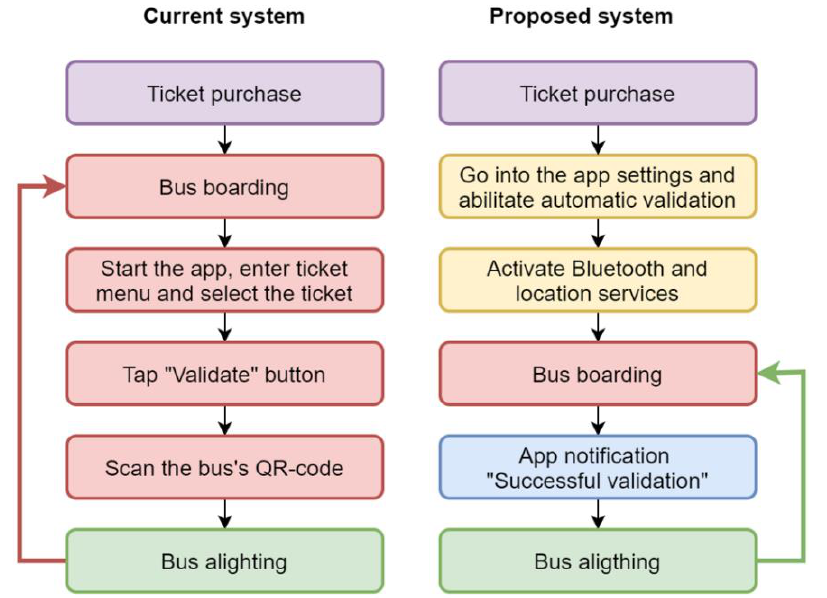
Figure 1. Flow diagrams for user actions before ( left ) and after ( right ) the introduction of automatic validation.